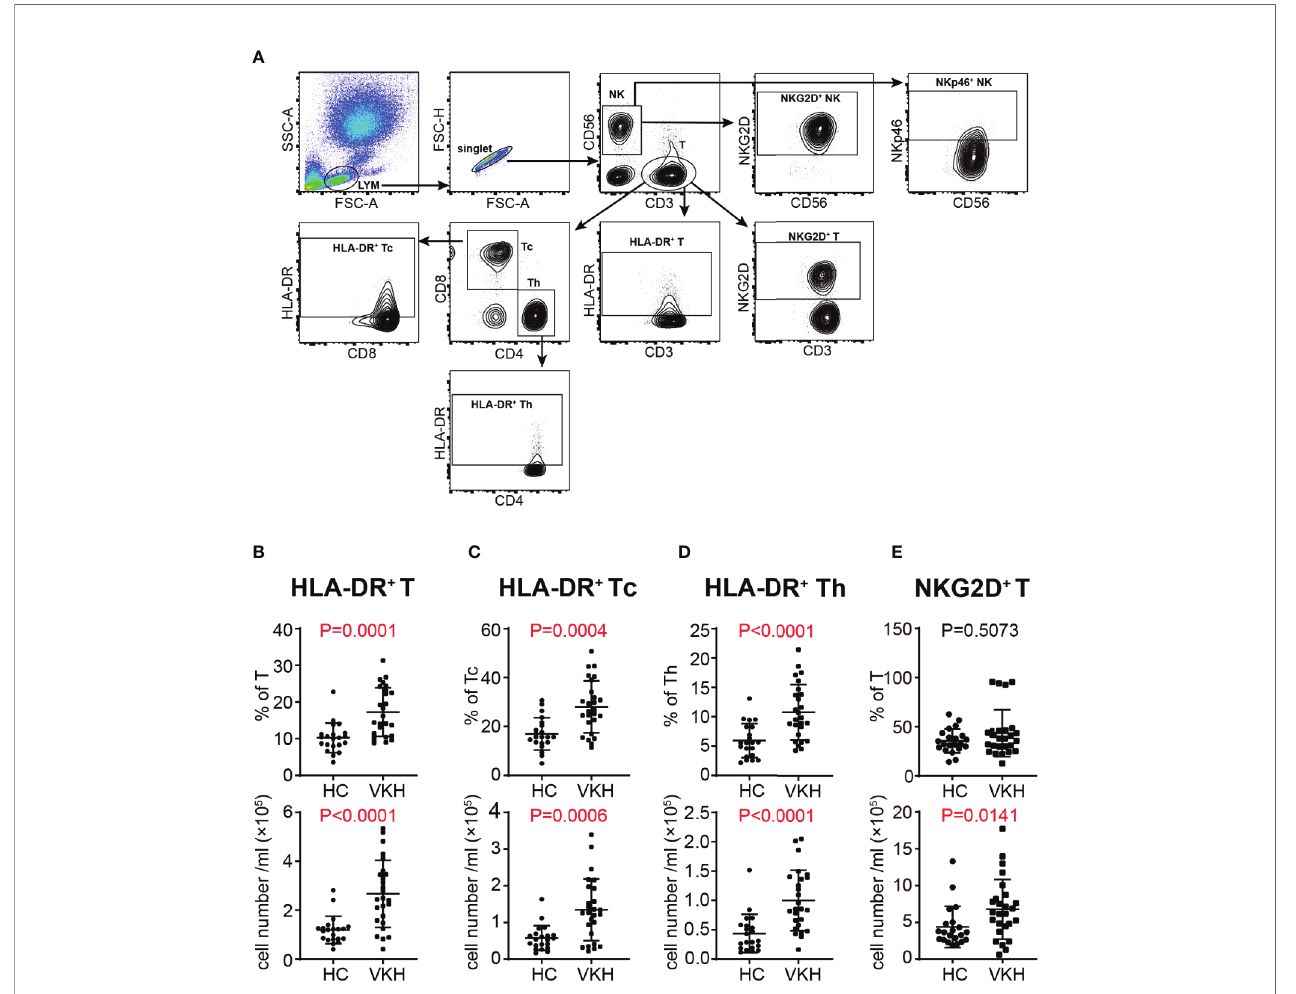
FIGURE 2 | Comparison of activated immune cells between VKH patients and healthy controls. (A) Gating strategy used for analysis of activated immune cells. (B) The absolute number and proportion of HLA-DR + CD3 + T cells. (C) The absolute number and proportion of HLA-DR + CD8 + T cells. (D) The absolute number and proportion of HLA-DR + CD4 + T cell. (E) The absolute number and proportion of NKG2D + T cells. Statistical analysis was performed using Mann – Whitney test. Th, helper T cells; Tc, cytotoxic T